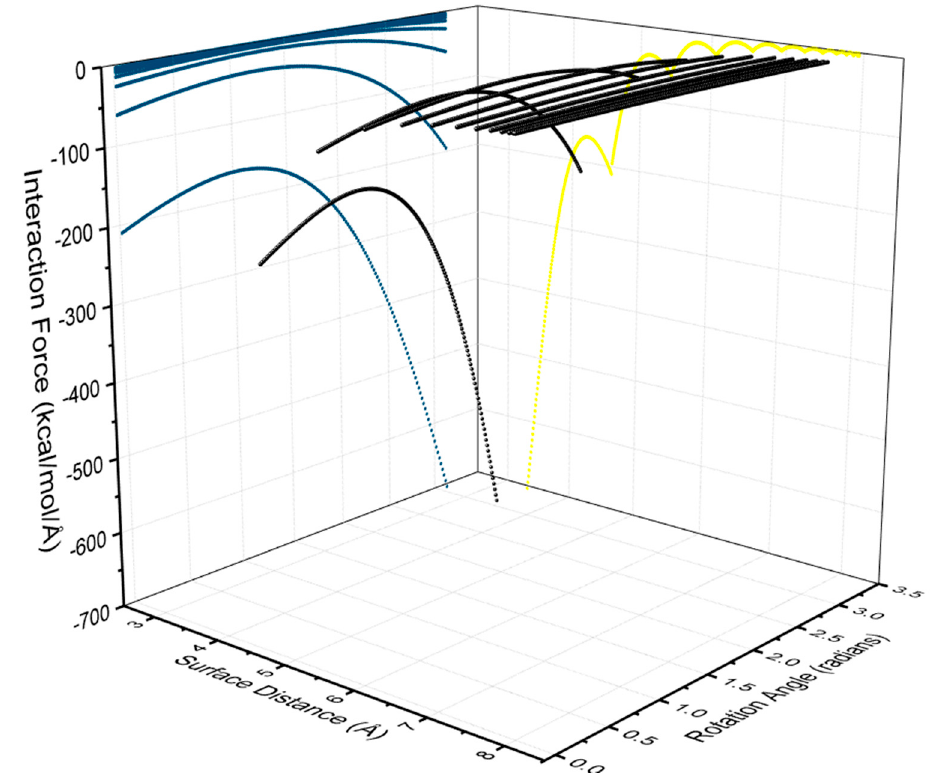
Figure 7. 3D image of interaction force (in black) of AuNRs with a diameter of 2 nm and aspect ratio of 4 with respect to surface separation and rotation angle. The projected curves indicate the dependence of force (in yellow) on surface separation and torque (in blue) on rotation angle, respectively